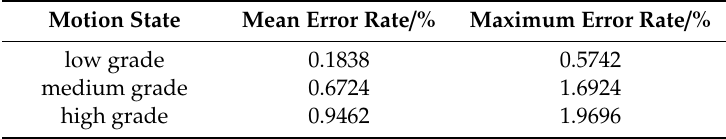
Table 5. Comparison of the average and maximum error rates for the three active